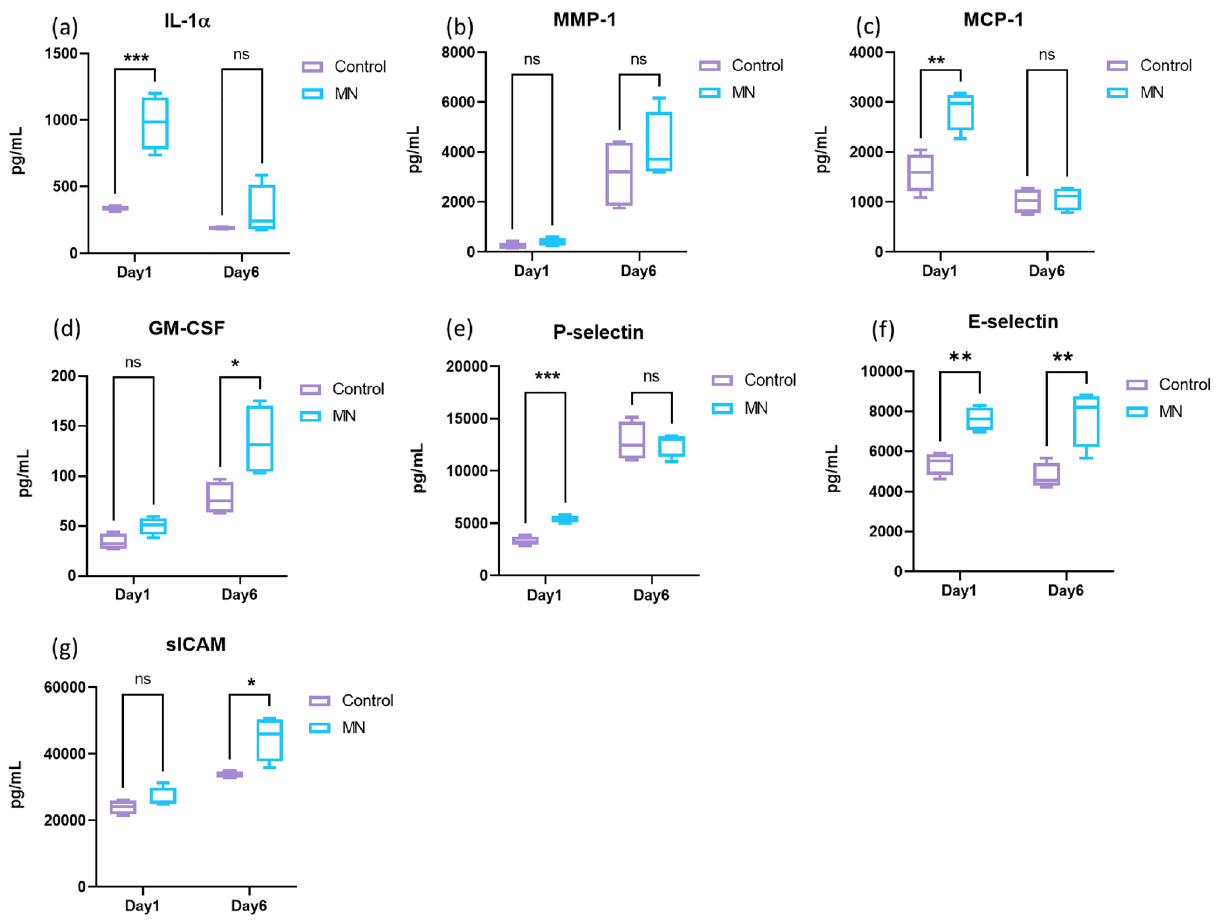
Figure 4. Quantification of pro-inflammatory cytokines in the ex vivo tissue. ( a – g ) The expression of growth factors was measured using a multiplex cytokine array. The media was collected on Day 1 and Day 6 (N = 4, 2 biological samples per donor, 2 donors). Student t-test, * P ≤ 0.05, ** P ≤ 0.01, *** P ≤ 0.001, **** P ≤